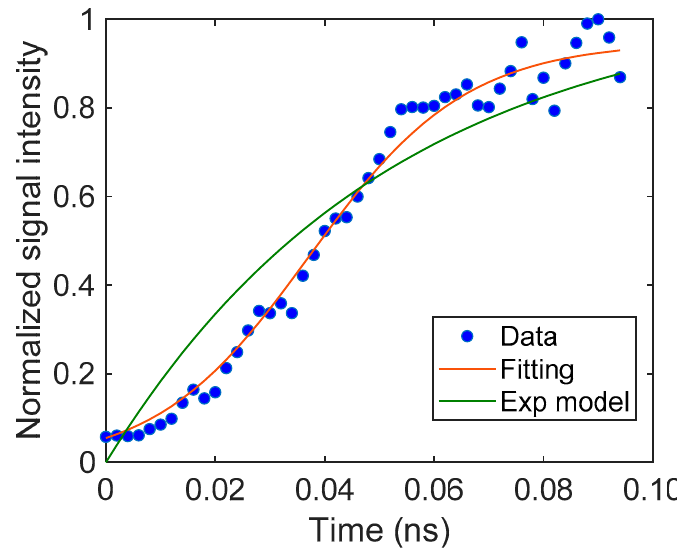
Figure 6. The rising part of the SrTiO 3 particulate film and the fitting curve obtained from Equation (7). The parameters were S = 0.436 (–), β = 0.145 ( μ m − 1 ), D N = 1.03 ( μ m 2 / μ s). For comparison, a fitting curve using an exponential model is also shown.